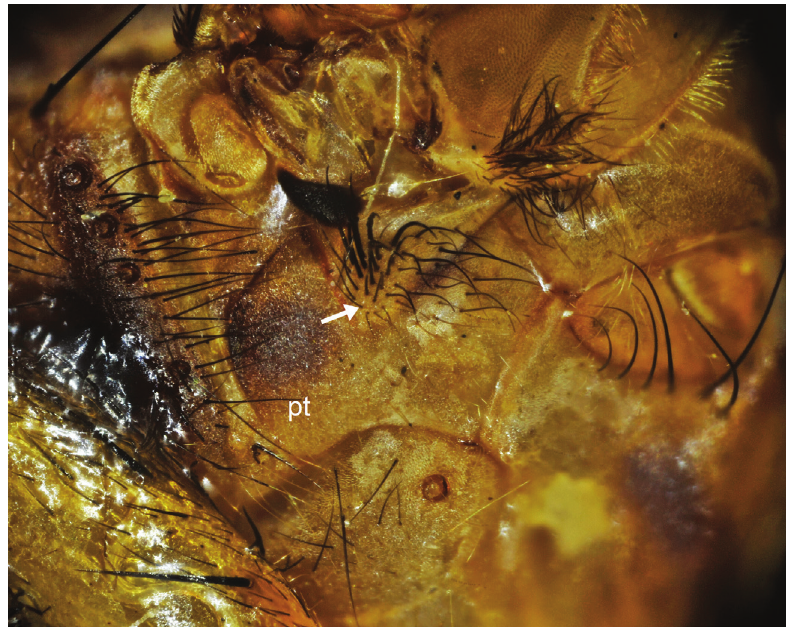
Figure 4. Pteropleuron (pt) of Bengalia fuscipennis Bezzi, which is largely covered with yellow hairs except for a tuft of blackish hairs. Arrow shows the blackish hair tuft.